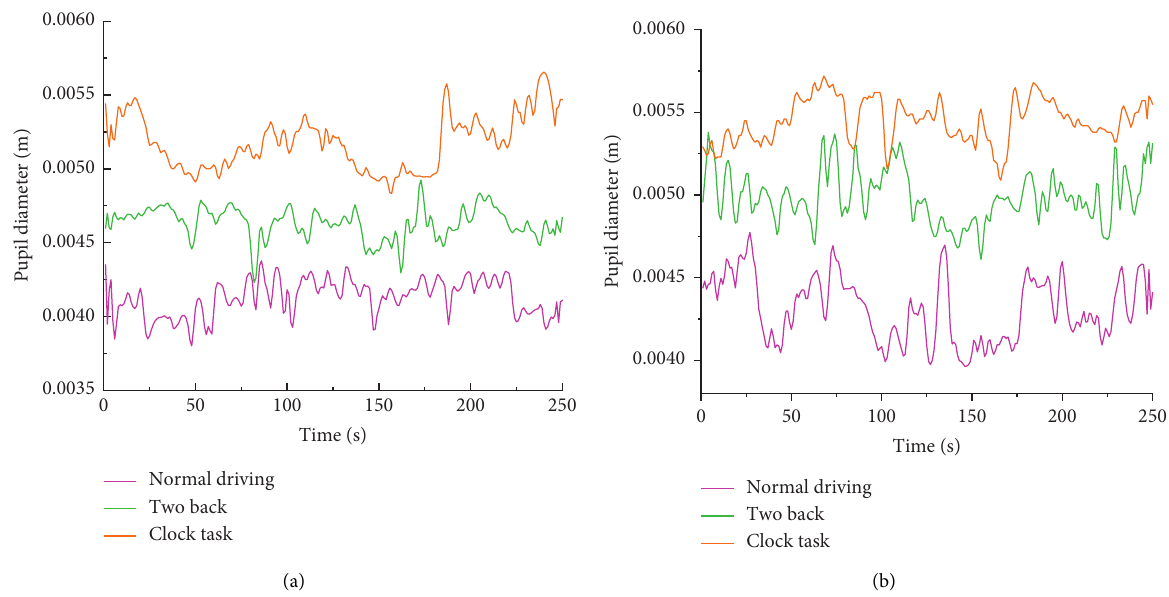
Figure 5: Change in pupil diameter in the (a) traditional traffic environment and (b) mixed traffic environment.